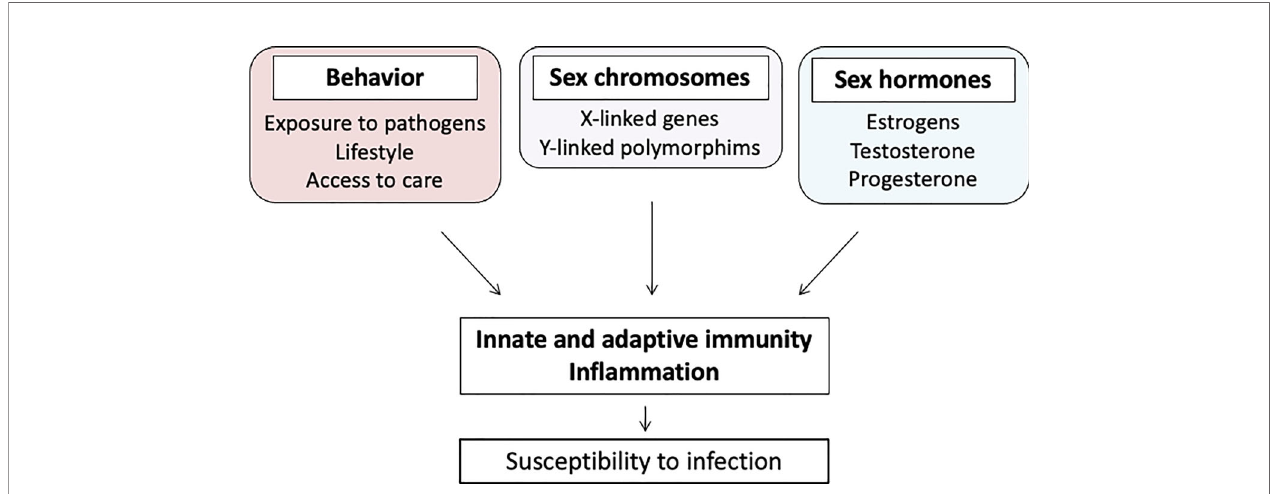
FIGURE 1 | Multifactorial mechanisms of gender